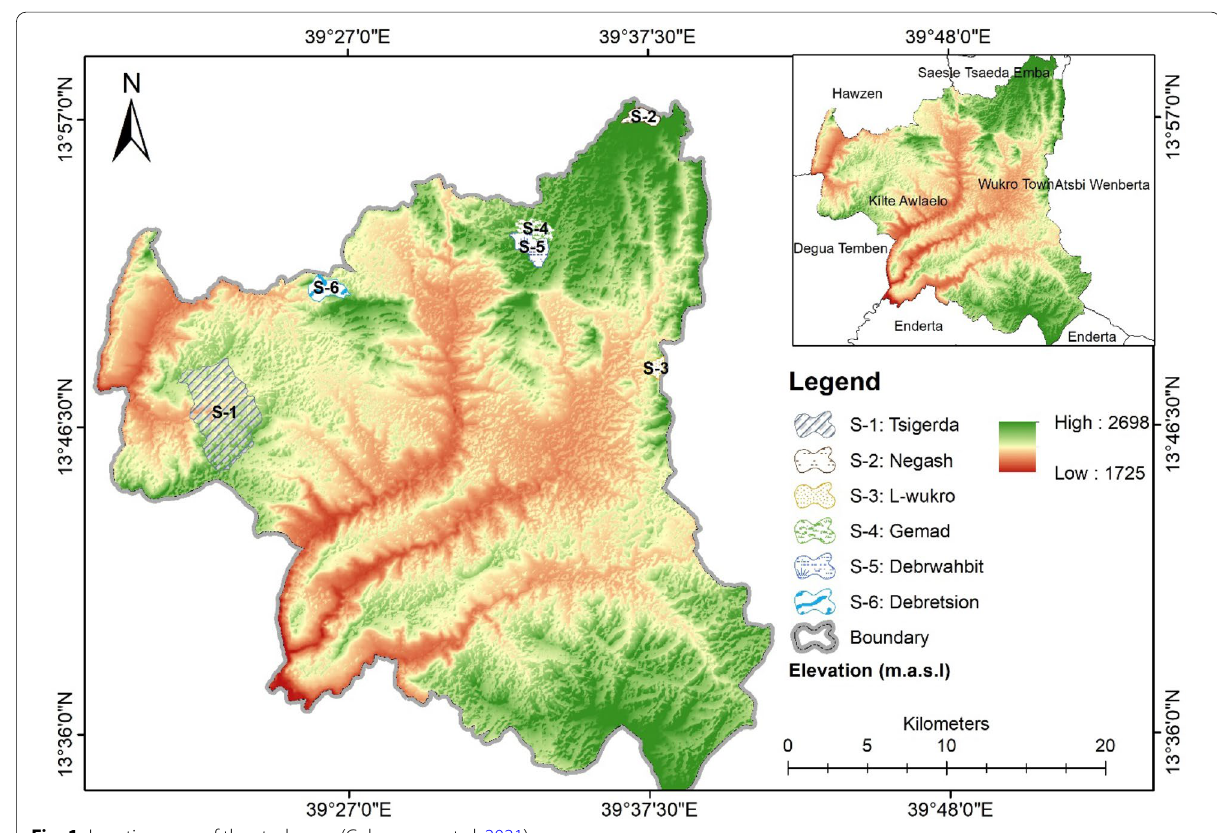
Fig. 1 Location map of the study area (Gebregergs et al.